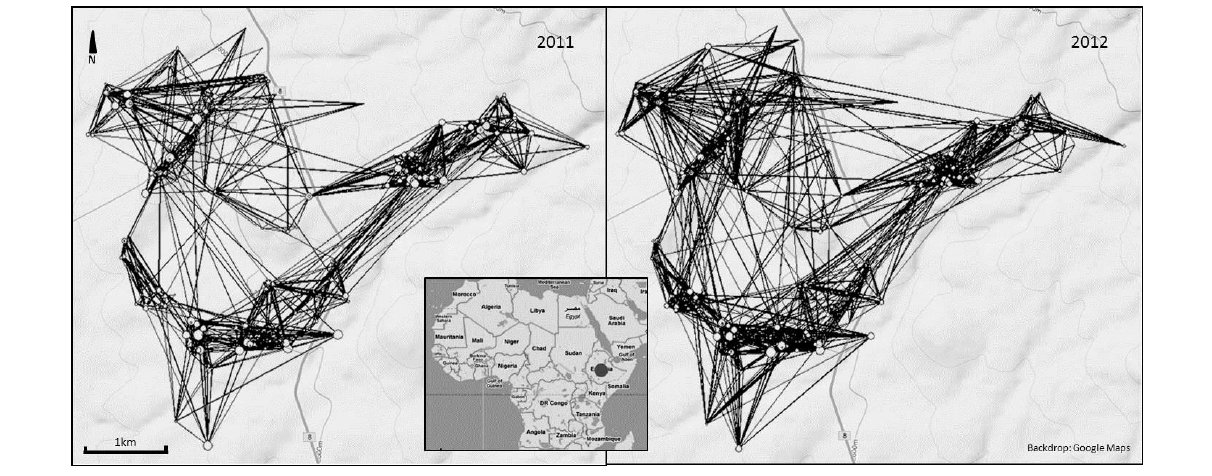
Fig. 1 . Learning networks in 2011 and